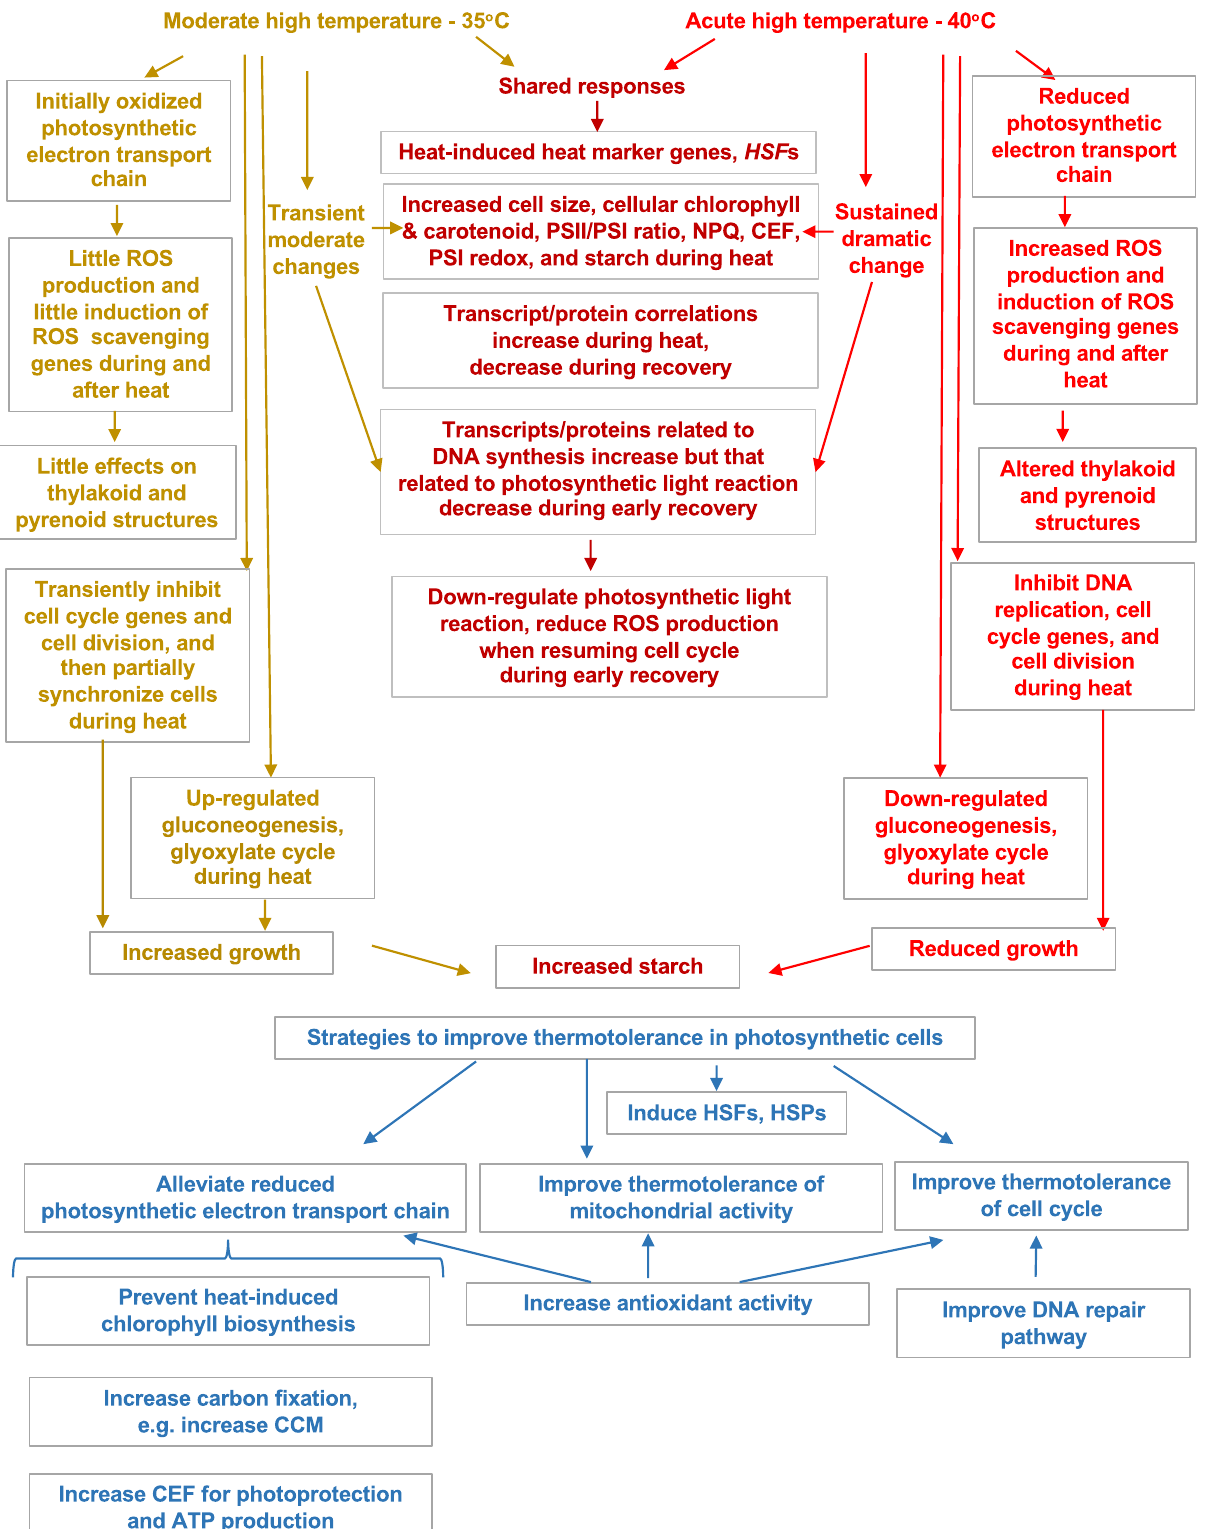
Fig. 10 Chlamydomonas has shared and unique responses to moderate and acute high temperatures of 35°C and 40°C. Top panel : Summarized results from multiple-level anlayses revealed the unique responses to 35°C (left, brown), unique to 40°C (right, bright red), and those shared between the two treatments (middle, dark red). Bottom panel (blue): Our results can be used to inform strategies to improve thermotolerance in photosynthetic cells.